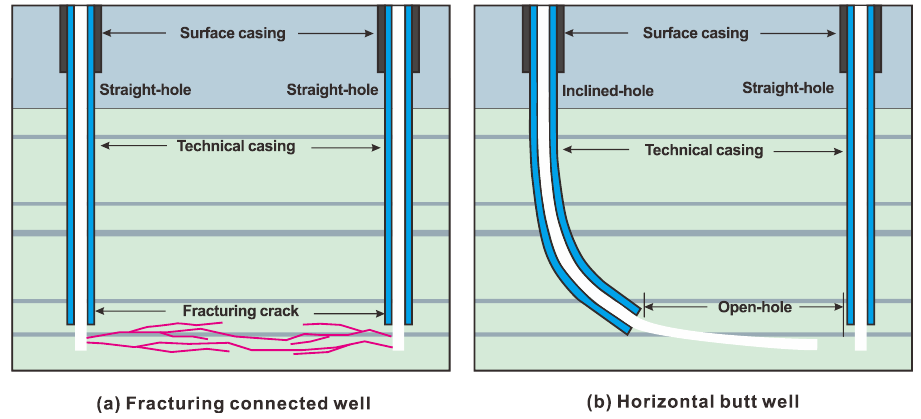
Figure 4. Horizontal convection well connection mode.